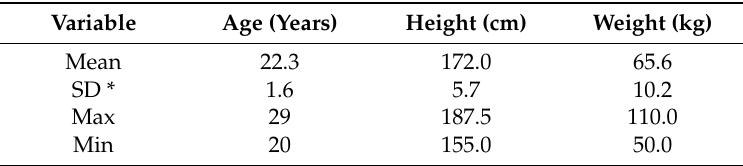
Table 1. Demographic parameters of the participants (n =